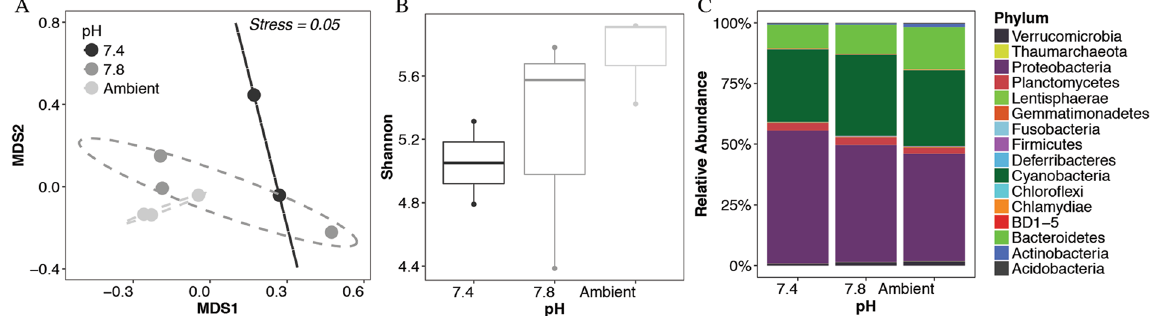
Figure 3. Microbial community response of 27-day old biofilms to ocean acidification. ( A ) Differences in communities, ( B ) Shannon diversity and ( C ) composition. Ambient pH was 8.1. Supplemental information and full data can be found in Figs. S1–4.